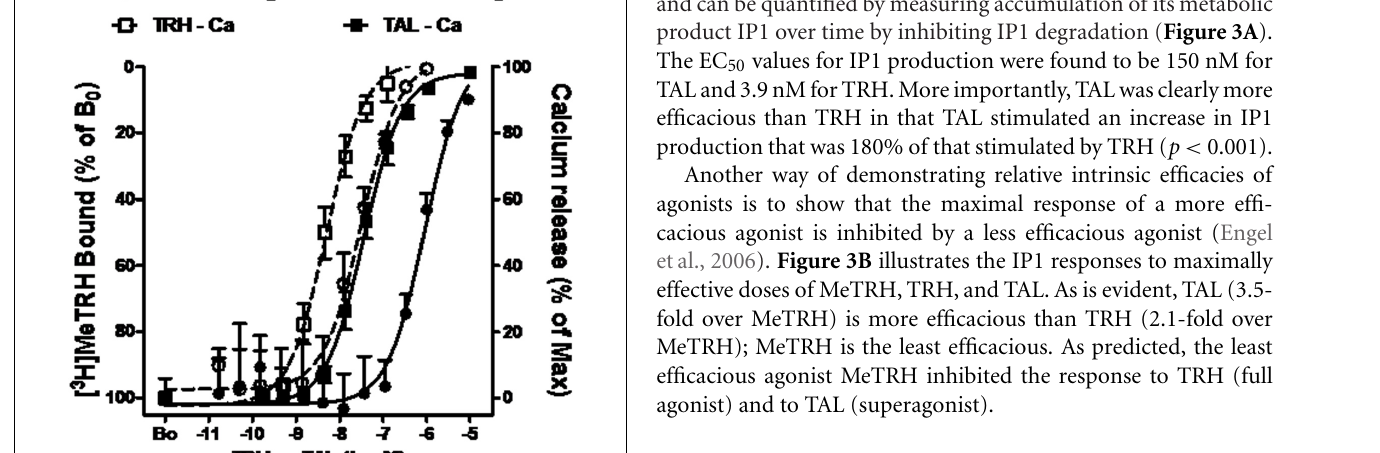
mouse TRH-Rs (Engel et al., 2006). As TRH is the natural, full agonist, TAL is termed a superagonist, and MeTRH is a partial agonist.